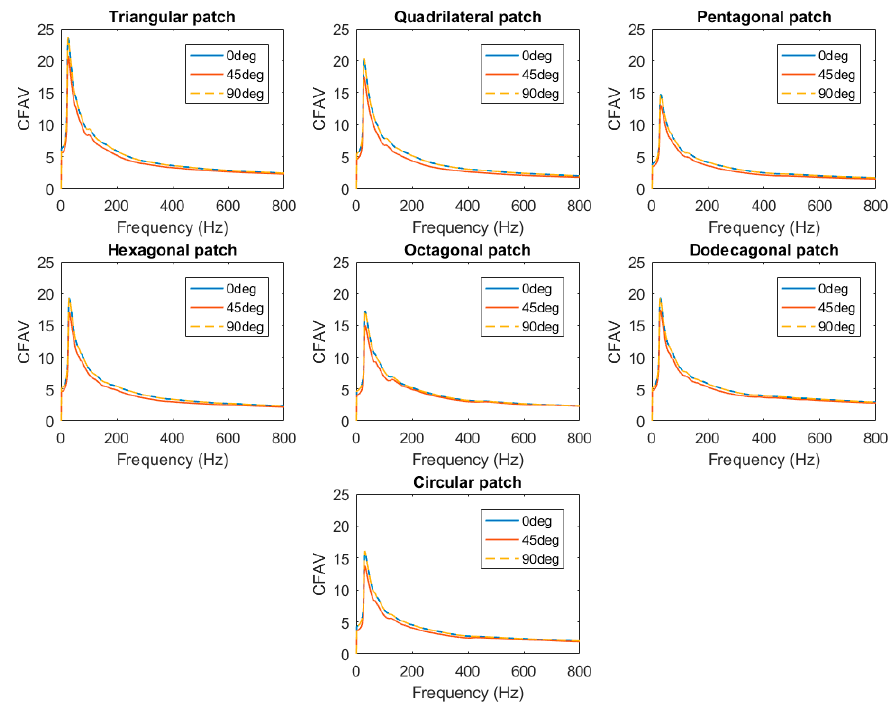
Figure 8. CFAV of the piezoelectric patches for optimal fiber orientation for single-lamina.